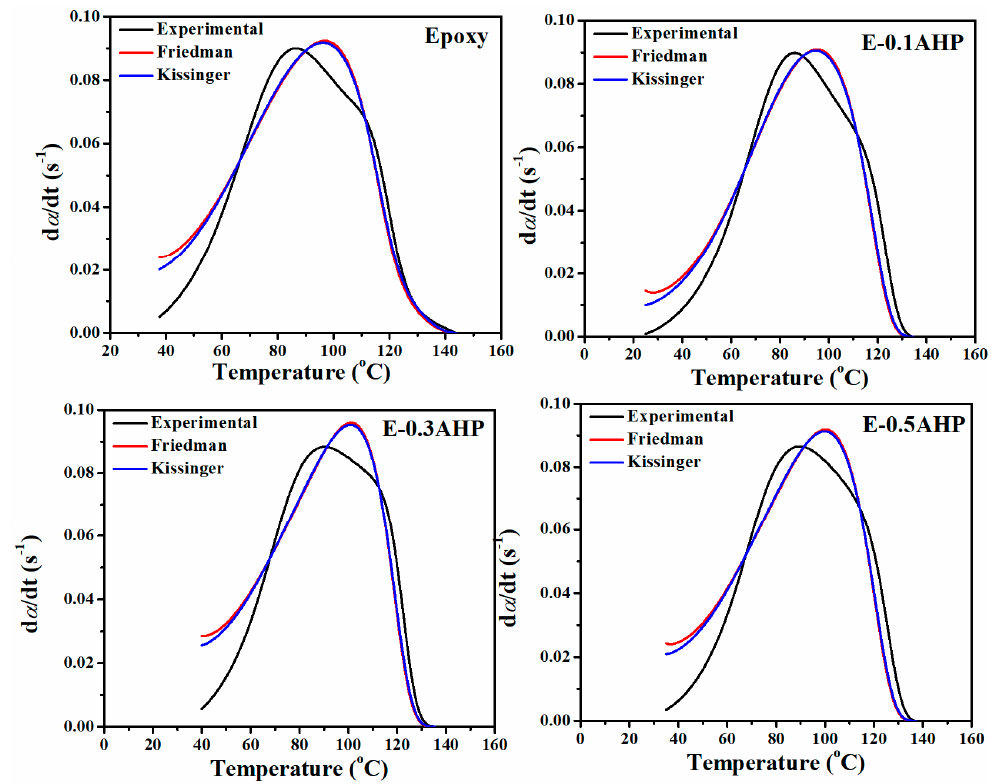
Figure 7. Comparison of experimental data with the kinetic models for the prepared samples at heating rate of 5 °C/min as a typical of computations done based on Friedman and Kissinger models.